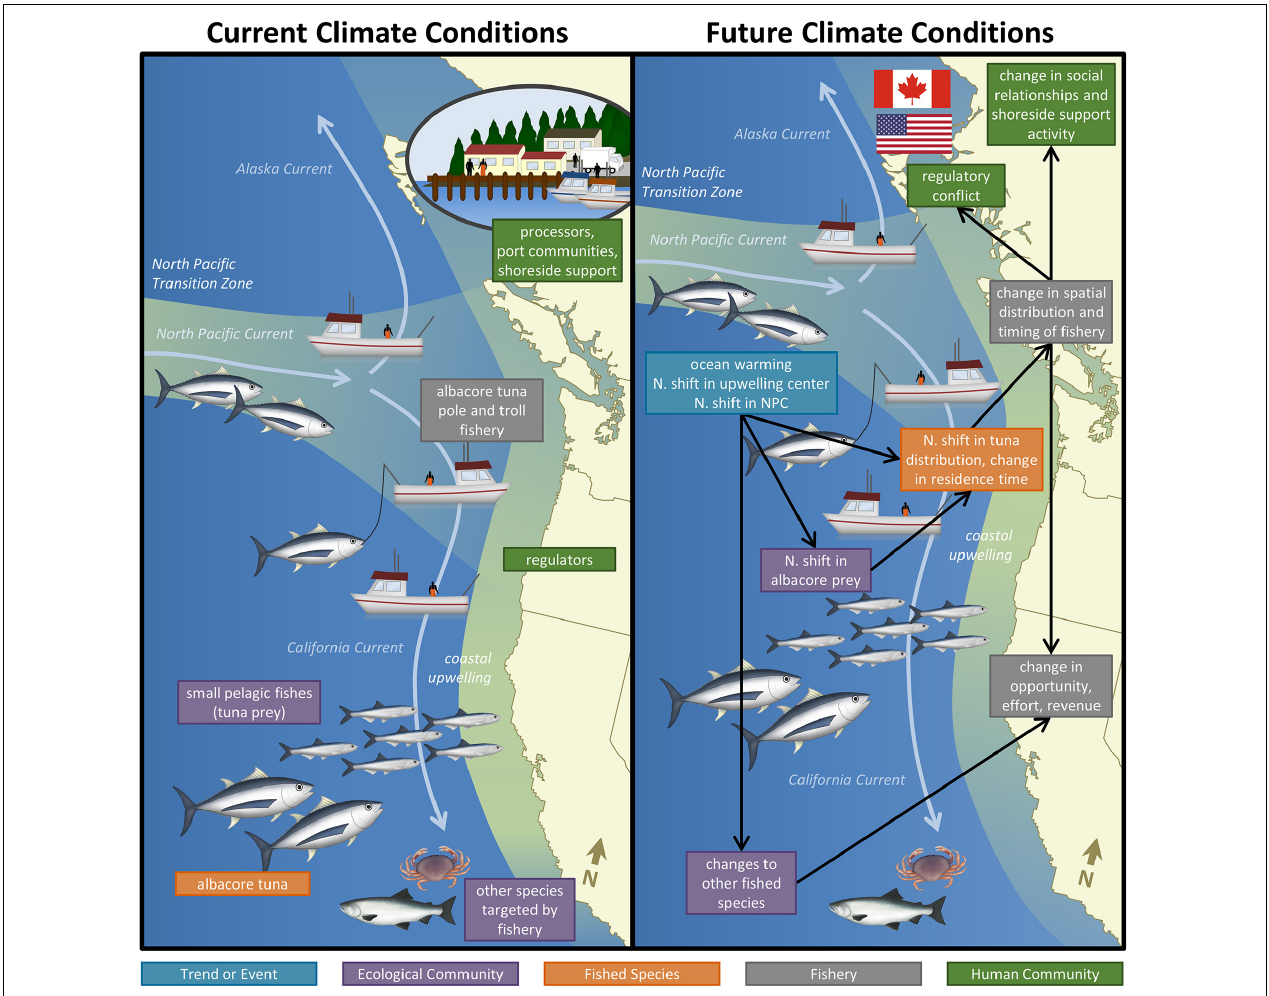
FIGURE 4 | Potential impacts of the climate change on the United States West Coast albacore tuna fishery system. Boxes are color coded by domain and indicate the major system components (Current Climate Conditions) and impacts of climate change (Future Climate Conditions). Black arrows connect exposures and